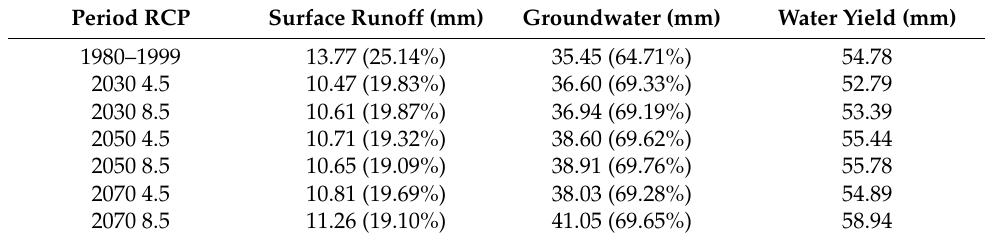
Table 7. Surface runoff (mm) and groundwater contribution (mm) to water yield for historical baseline and three future periods (2030s, 2050s, 2070s) under two RCPs (4.5, 8.5) in Deckers Creek Watershed, Morgantown, West Virginia, USA. The number in the parentheses shows the percent contribution of surface runoff and groundwater to water